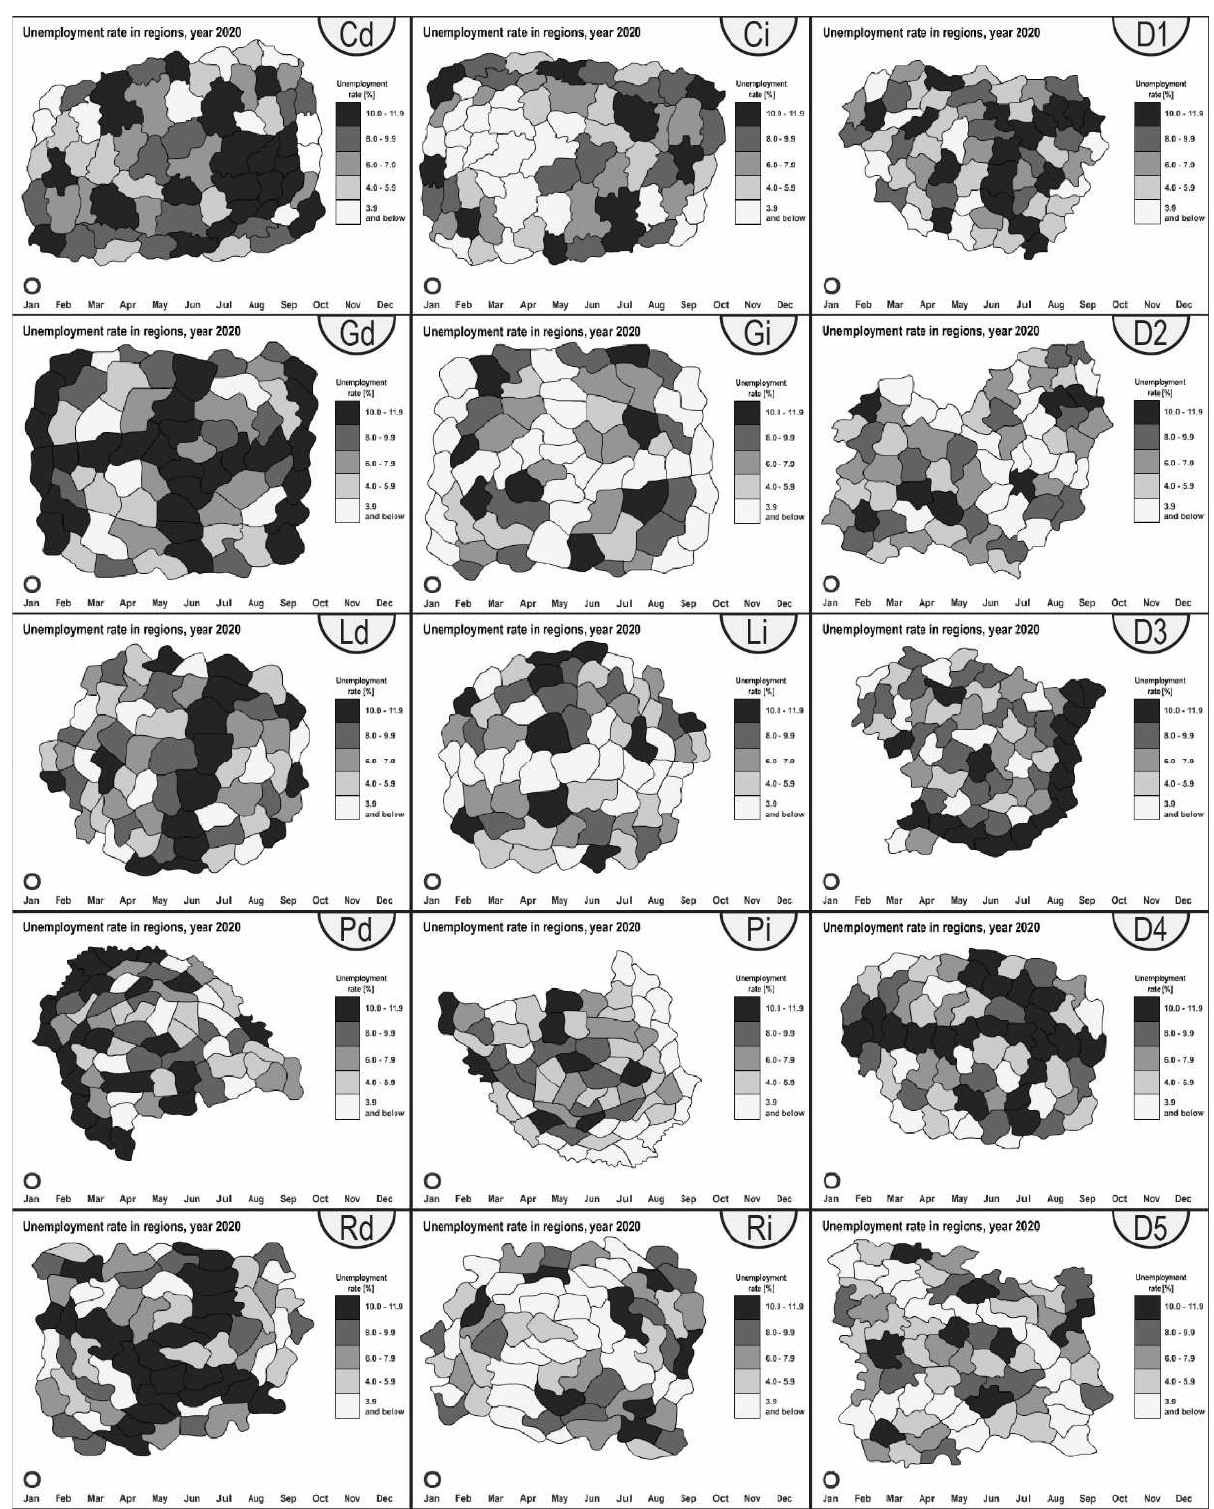
Figure 1. Map stimuli used in the research. Spatial patterns: C: clustered, G: grid, L: linear, P: peripheral, R: radial, D: dispersed. Temporal trends: d: decrease, i: increase.